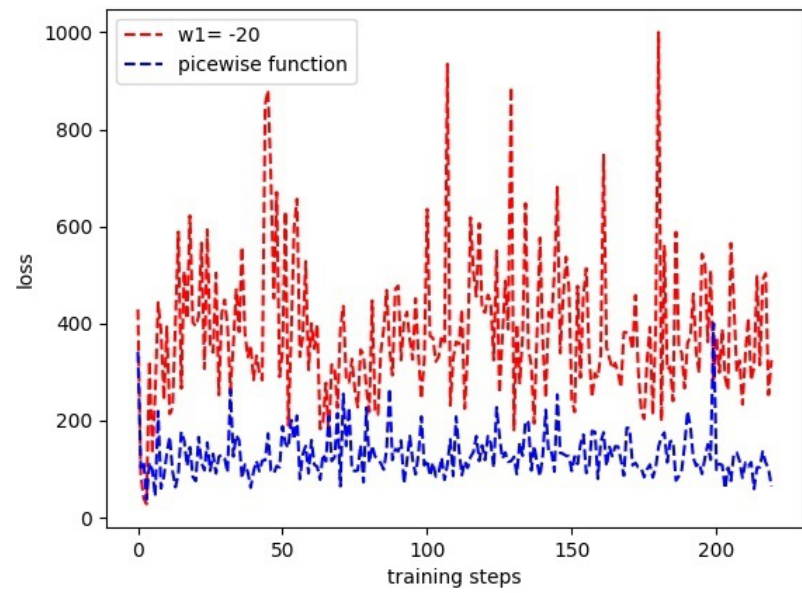
Figure 10. Comparison of loss with different forms of scale factors